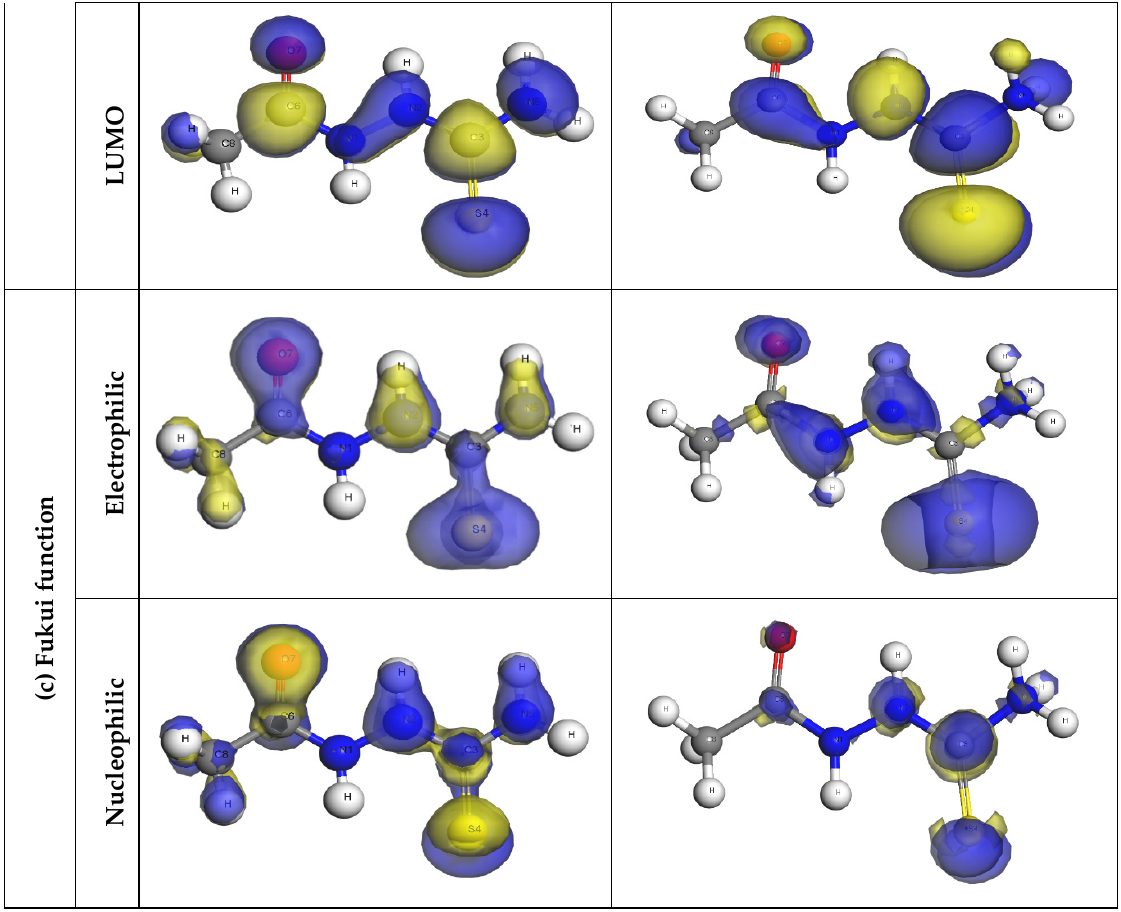
Figure 9. ( a ) Optimized geometric structures, ( b ) molecular orbitals and ( c ) Fukui function for AST and ASTH at the GGA/BLYP/DNP level of theory.